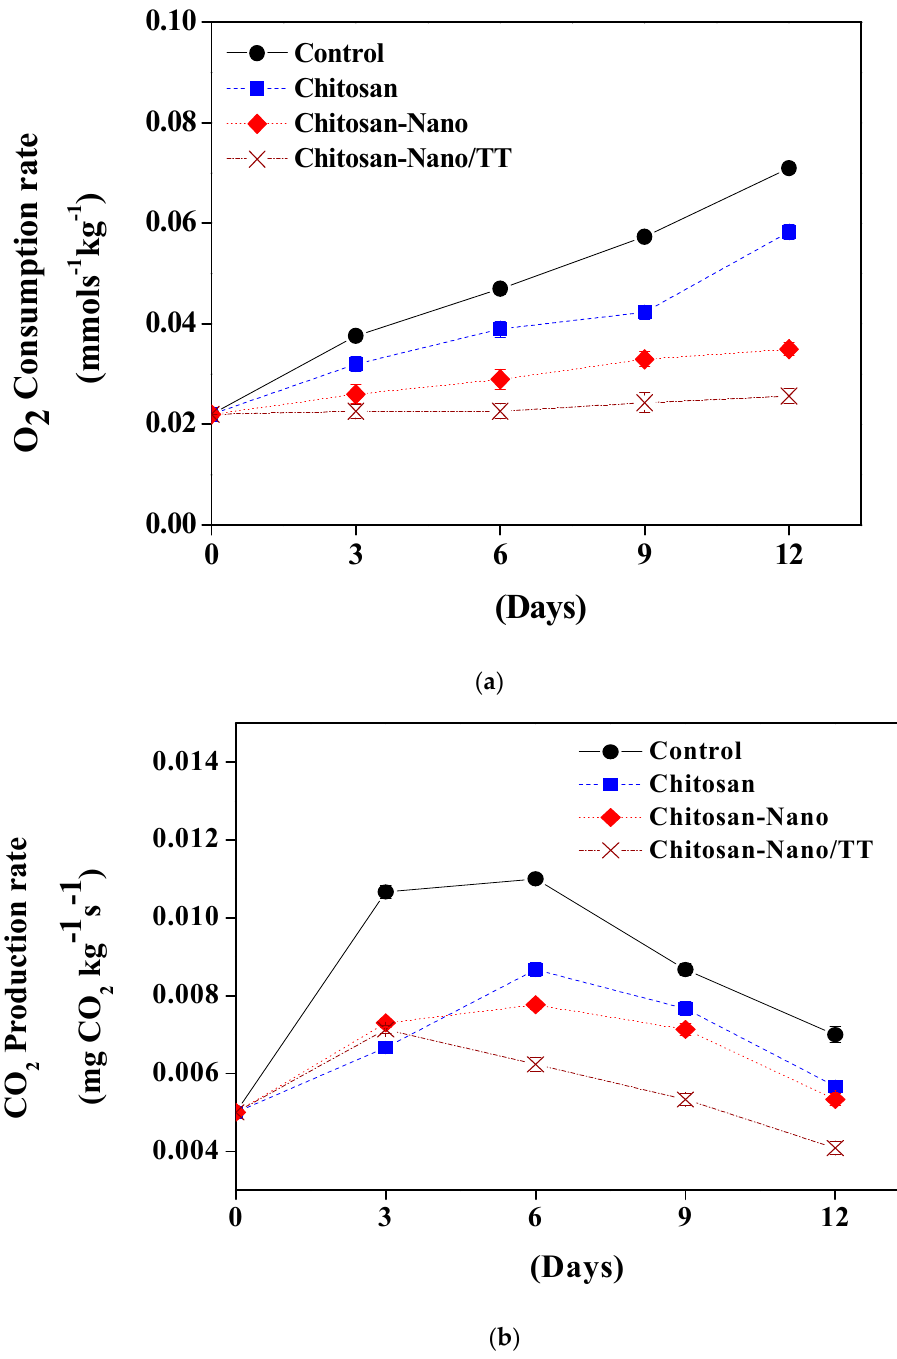
Figure 4. Effect of respiration rates on mushrooms during storage; O 2 consumption ( a ) and CO 2 production rates ( b ).